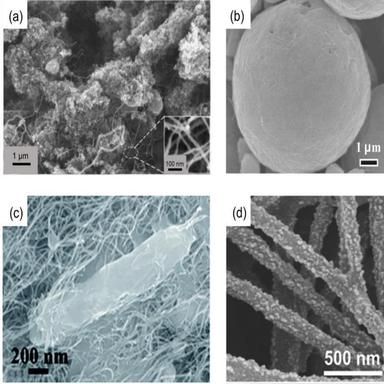
The SEM images of (a) Li2S/KB@Cf , (b) Li2S-C-N-O@CNT , (c) Li2S@C-CNT, and (d) Li2S@NCNF . Reproduced from Refs. with permission from Elsevier, Royal Society of Chemistry, and Wiley.